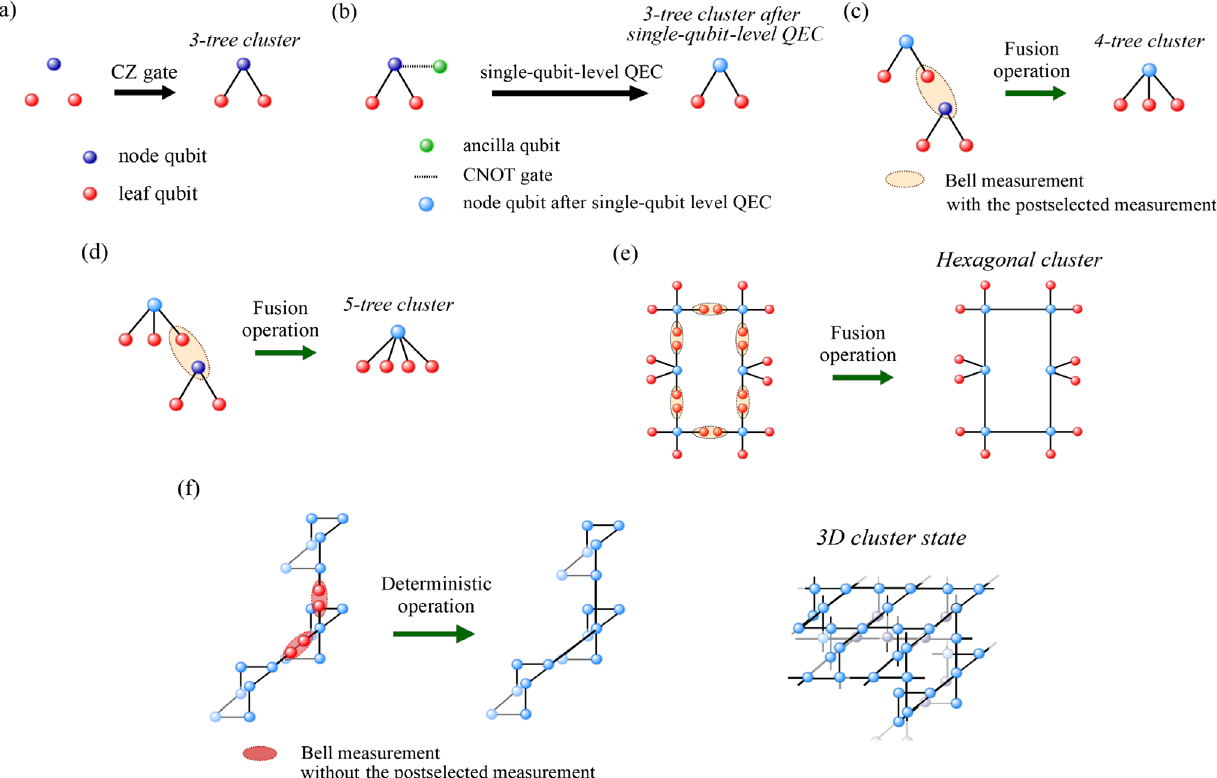
FIG. 6. The 3D cluster-state construction. (a) The preparation of the 3-tree cluster state by using the CZ gate. (b) The single-qubit-level QEC using the additional ancilla qubit with the postselected measurement. (c) – (e) The construction of the hexagonal cluster state from the 3-tree qubit with the postselected measurement. (f) The construction of the 3D cluster state from the hexagonal cluster states, where the entanglement is generated between the neighboring hexagonal cluster states without the postselected